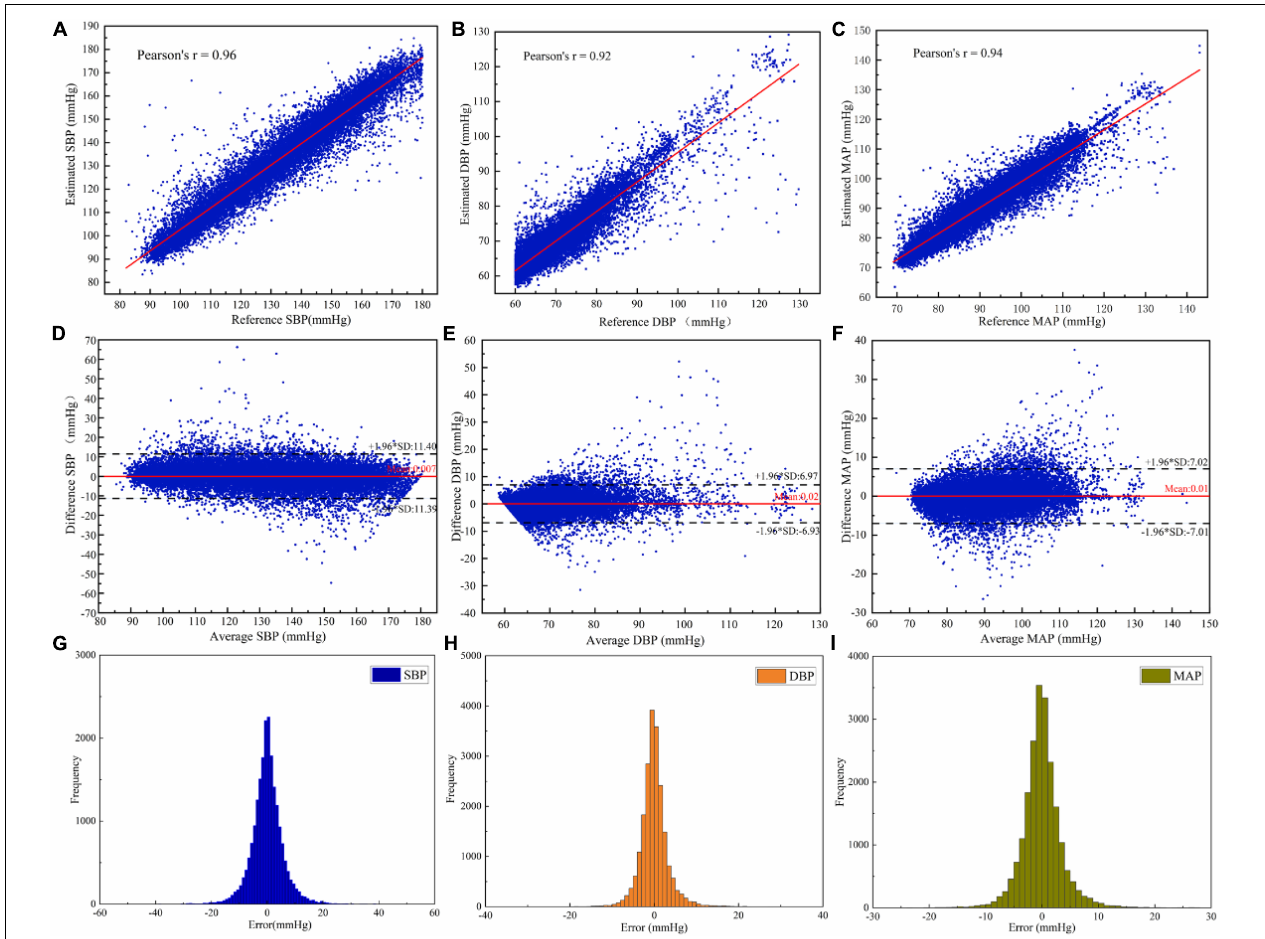
FIGURE 4 | Evaluation of the estimated BP performance of the MST-net model: (A) SBP correlation coefficient plot; (B) DBP correlation coefficient plot; (C) MAP correlation coefficient plot; (D) Bland-Altman plot of SBP; (E) Bland-Altman plot of DBP; (F) Bland-Altman plot of MAP; (G) Error histogram for SBP; (H) Error histogram for DBP; and (I) Error histogram for MAP.